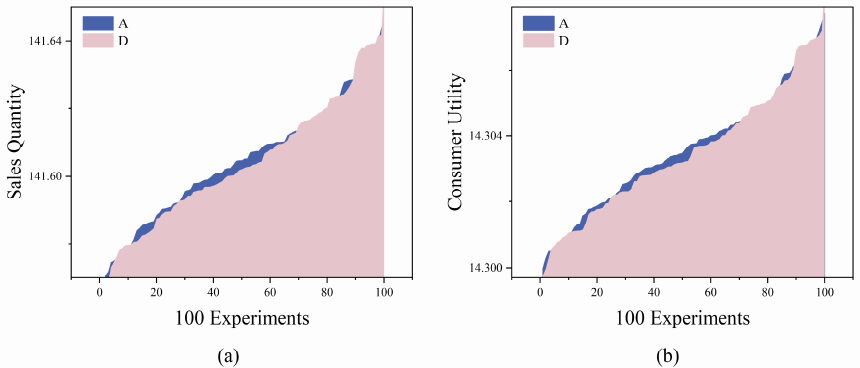
Figure 12. Prices in A and D of: ( a ) high-quality product in retail channel; ( b ) low-quality product in retail channel; ( c ) high-quality product in direct sales channel; ( d ) low-quality product in direct sales channel. ( t =